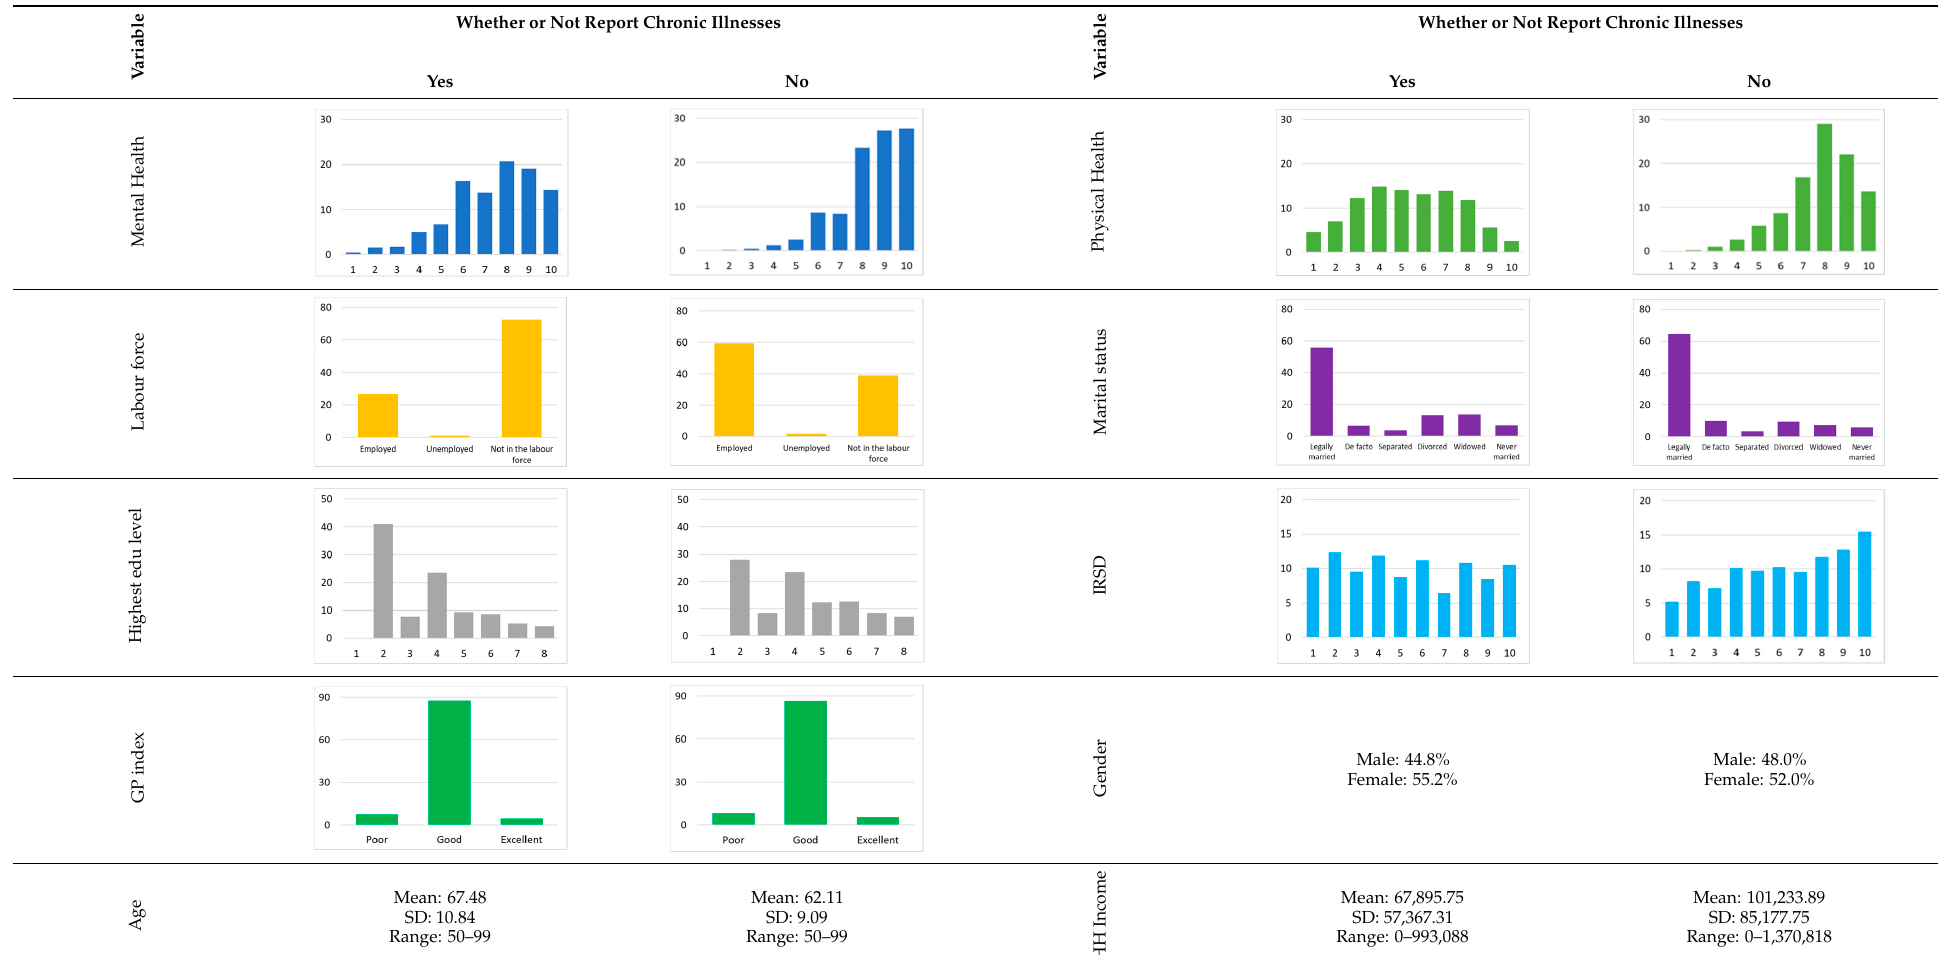
Table 2. Statistical summary of variables in older adult groups with/without reporting chronic illnesses.